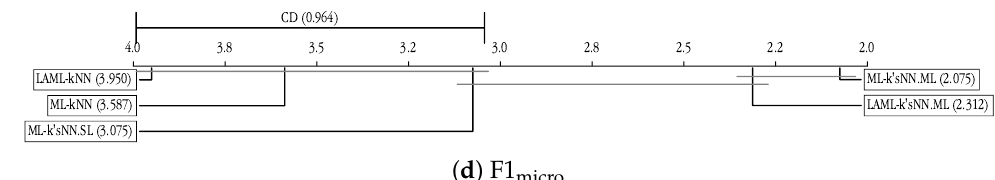
Figure 2. Nemenyi test for the different methods and the different classification metrics.